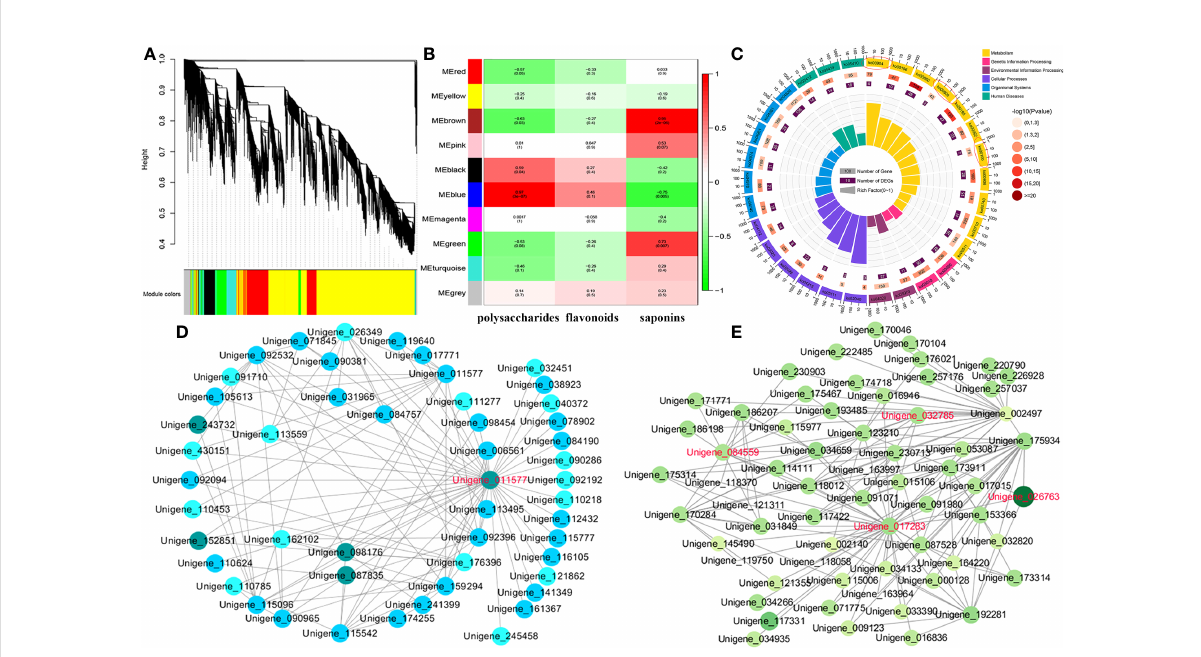
FIGURE 5 Hub genes related to polysaccharides, saponins, and fl avonoids accumulation. (A) Cluster dendrogram of DEGs for WGCNA analysis. (B) Gene modules associated with the content of polysaccharides, fl avonoids, and saponins. (C) Enrichment analysis of DEGs in the brown and green modules. (D) Co-expression network revealing the hub genes related to saponins content in the brown and green modules. (E) Co-expression network revealing the hub genes related to polysaccharides content in the blue